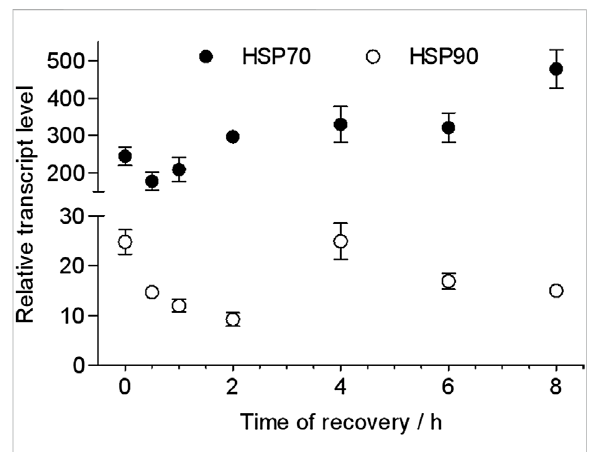
Peak relative transcript levels of HSP70 and HSP90 at differentrecoverytimesafterheatshockat43 Cfor2 h.Thevalues from two independent replicates are shown as the mean ± SD and analyzed by the 2 − △△ CT